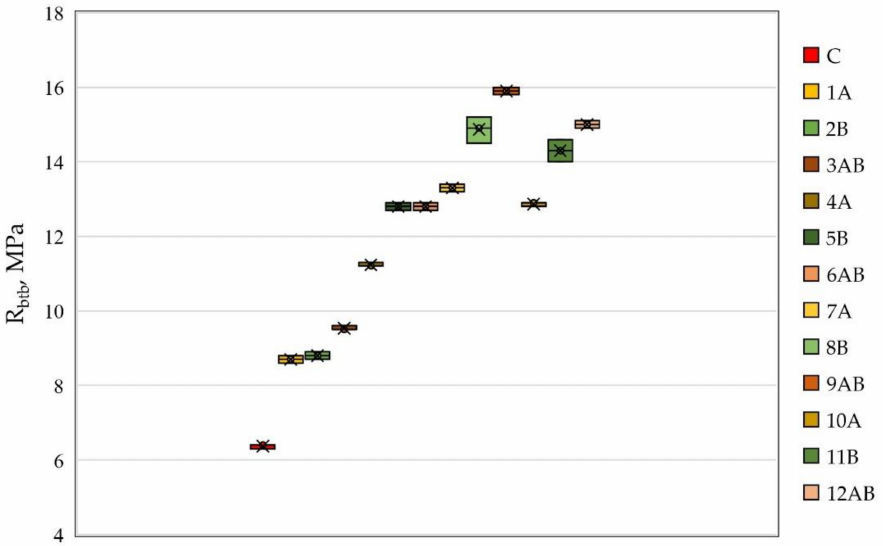
Figure 2. The tensile strength of fiber cement specimens depending on the type of dispersed